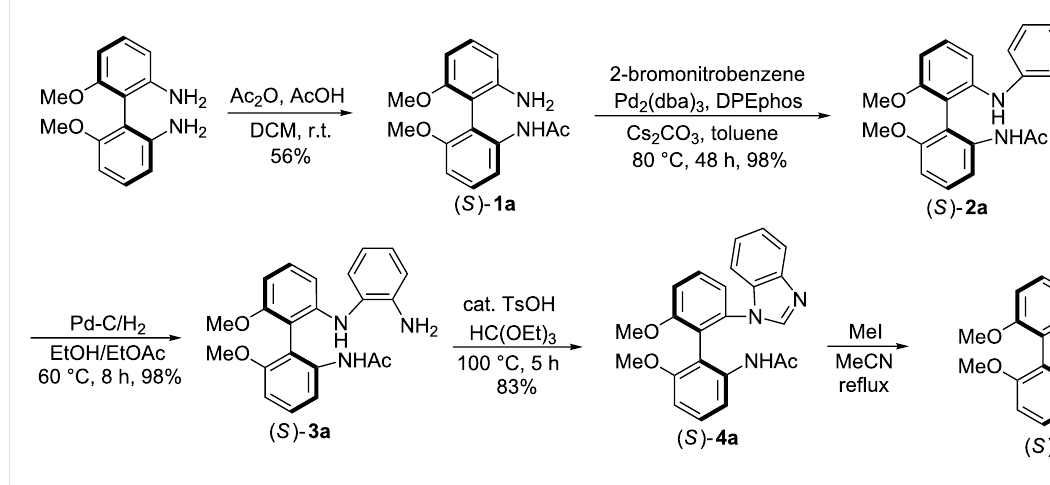
Scheme 1: Synthesis of N-heterocyclic carbene precursor.